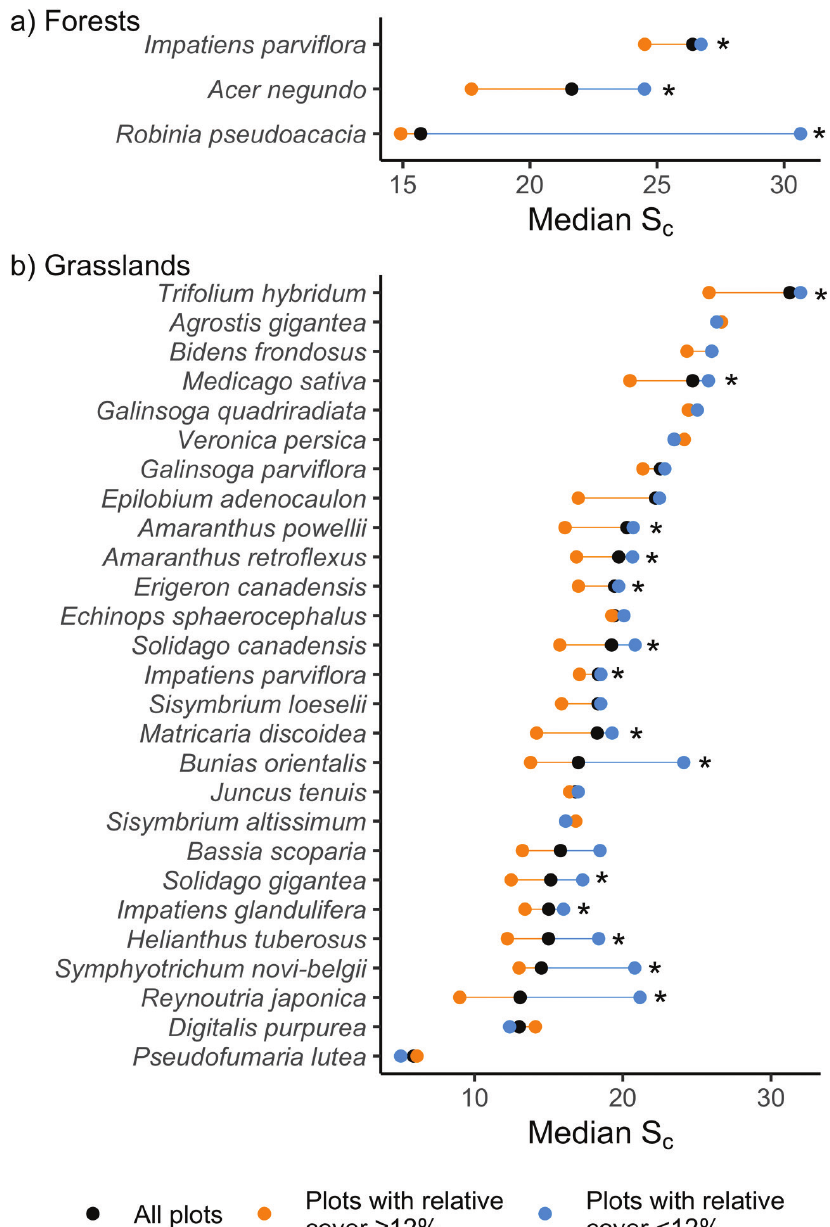
Figure 5. Median S of naturalised neophytes across all plots where they occurred and in plots with rela- c tive cover greater or smaller than 12%. Species are classified, based on their occurrence in ( a ) forests and ( b ) grasslands. Only species that occurred in at least ten plots in each group of plots (i.e. those with rela- tive cover ≥ 12% vs. those with relative cover < 12%) were considered. Asterisks (*) indicate significant ( P < 0.05) differences in median S between groups following Mann-Whitney U Tests. Median S c number of plots associated with each species can be found in Suppl. material 1: Appendix S5: Table